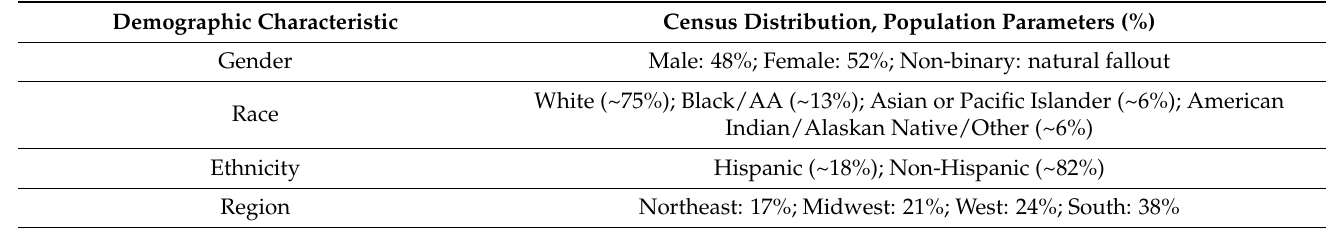
Table 1. Census distribution by gender, race, ethnicity, and region. Demographic Characteristic Census Distribution, Population Parameters